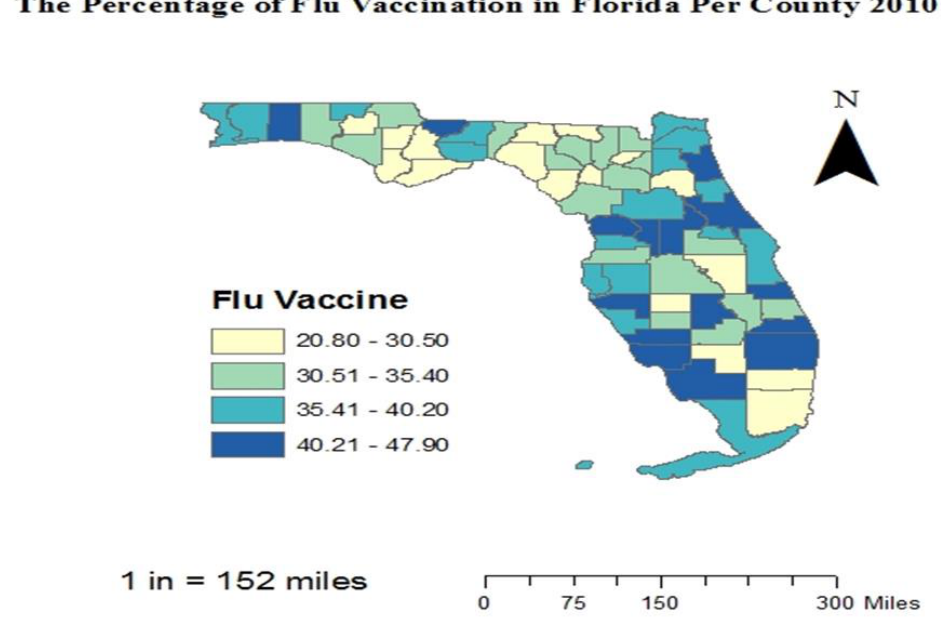
Figure 2. Vaccination rates per county in Florida.